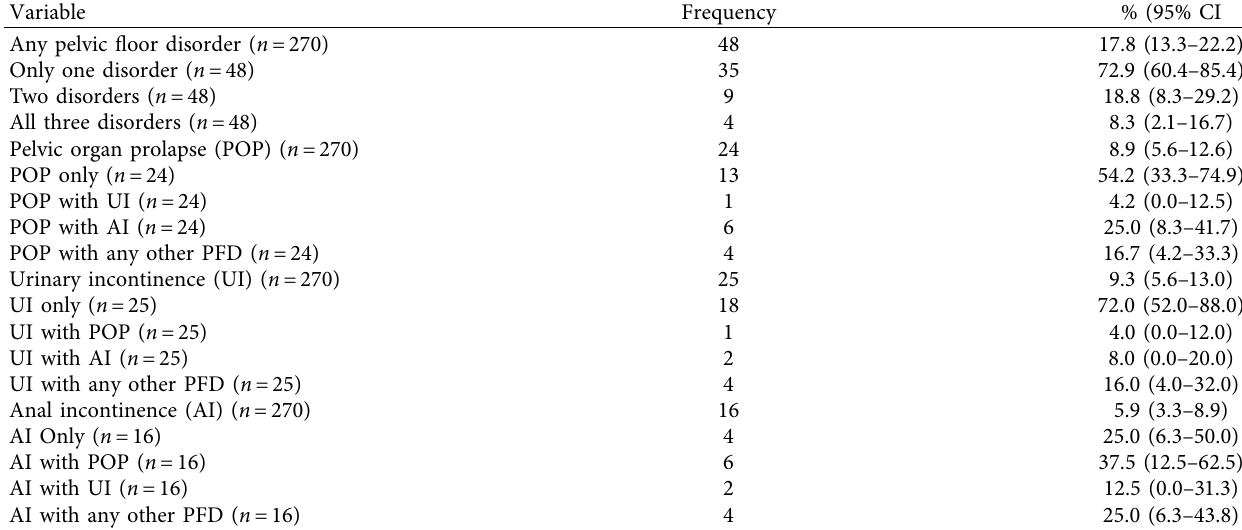
Table 3: Prevalence and cooccurrence of pelvic floor disorder among study participants.